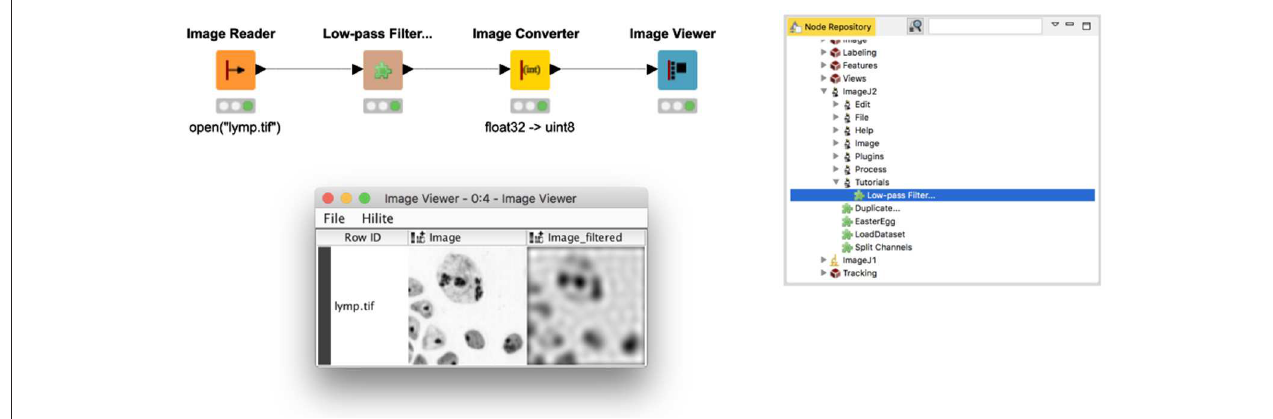
FIGURE 2 | An ImageJ command for low-pass filtering used as a KNIME